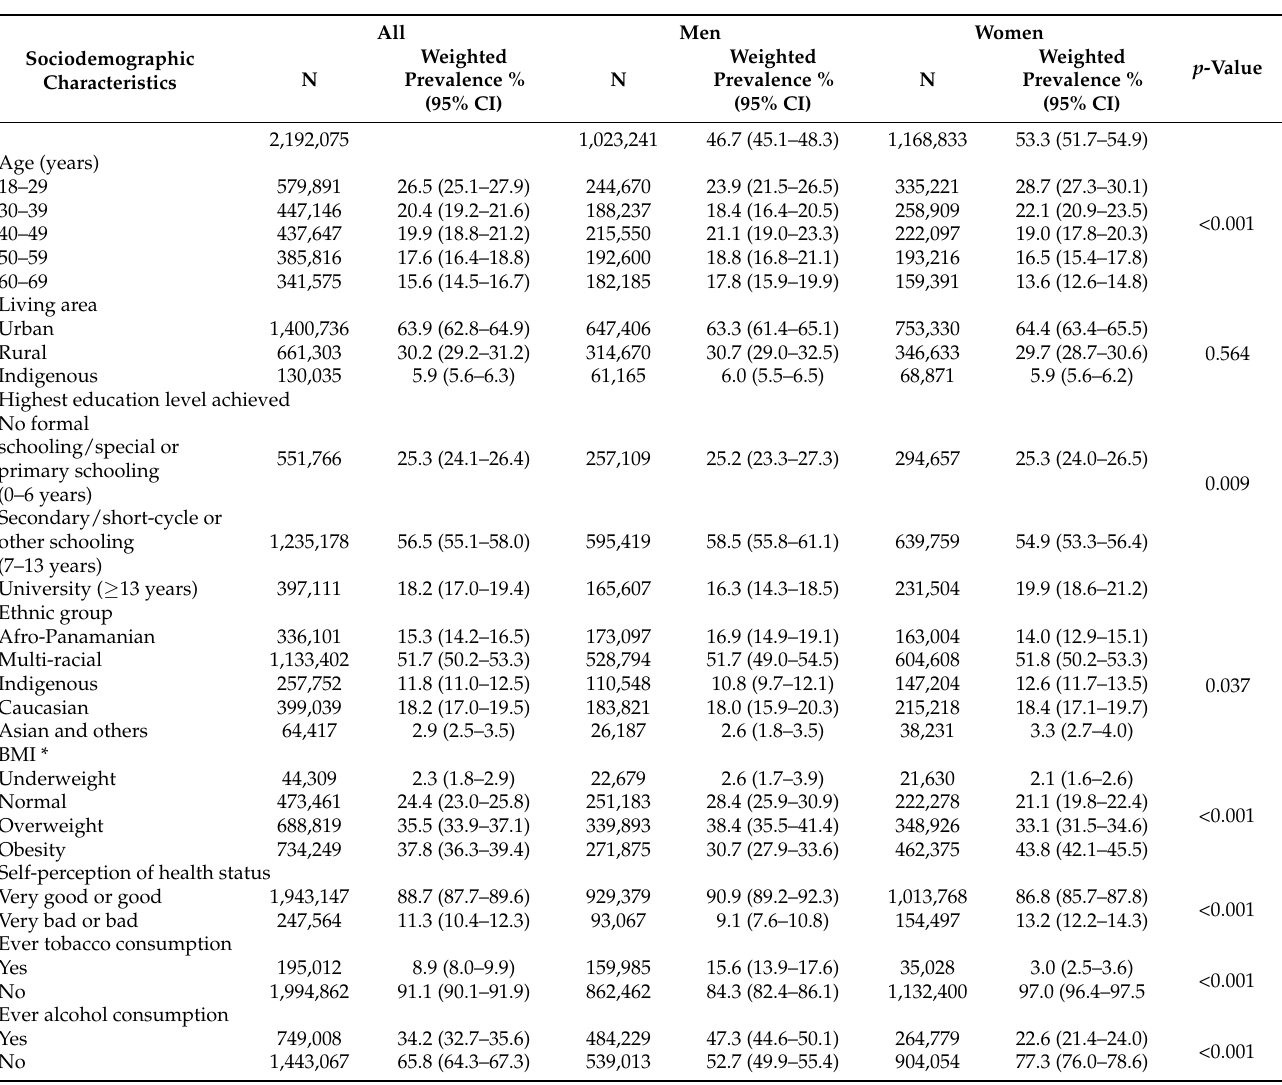
Table 1. Selected baseline characteristics of the study participants aged 18-69 years by sex. Panama,